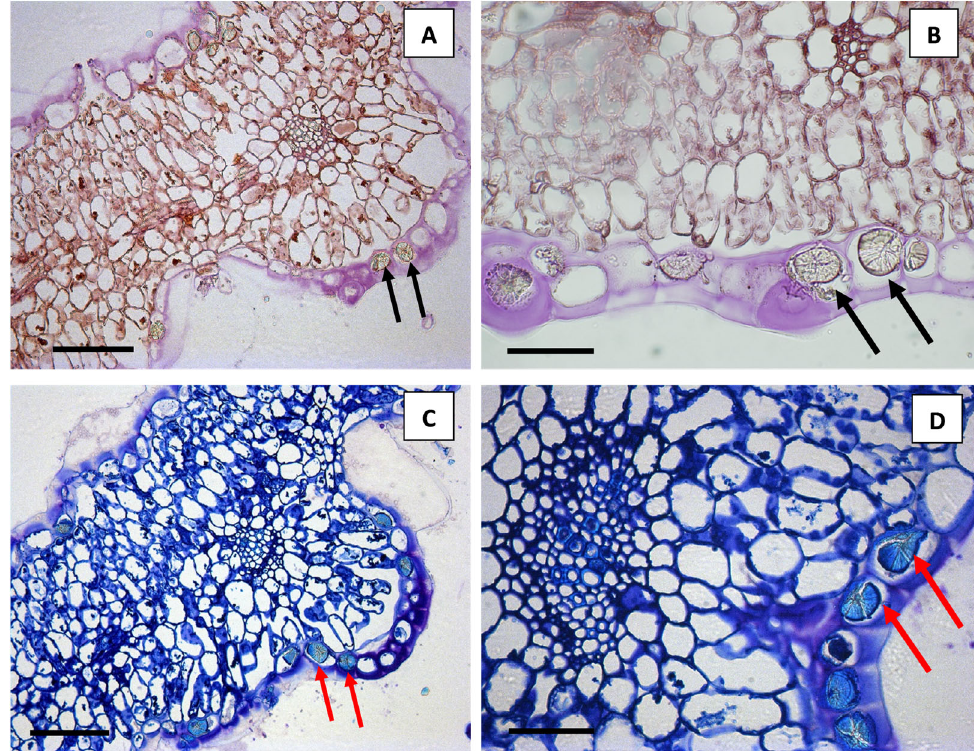
Figure 2. Leaf semithin transversal sections (( A , B ) hematoxylin–eosin staining; ( C , D ) TBO staining). Diosmin spherocrystals appeared unstained with hematoxylin–eosin (( A , B ) black arrows) but showed typical bright-blue staining of phenolic compounds with TBO (( C , D ) red arrows). Scale bars: A = 100 μ m; B = 50 μ m; C = 100 μ m; D = 50 μ m.